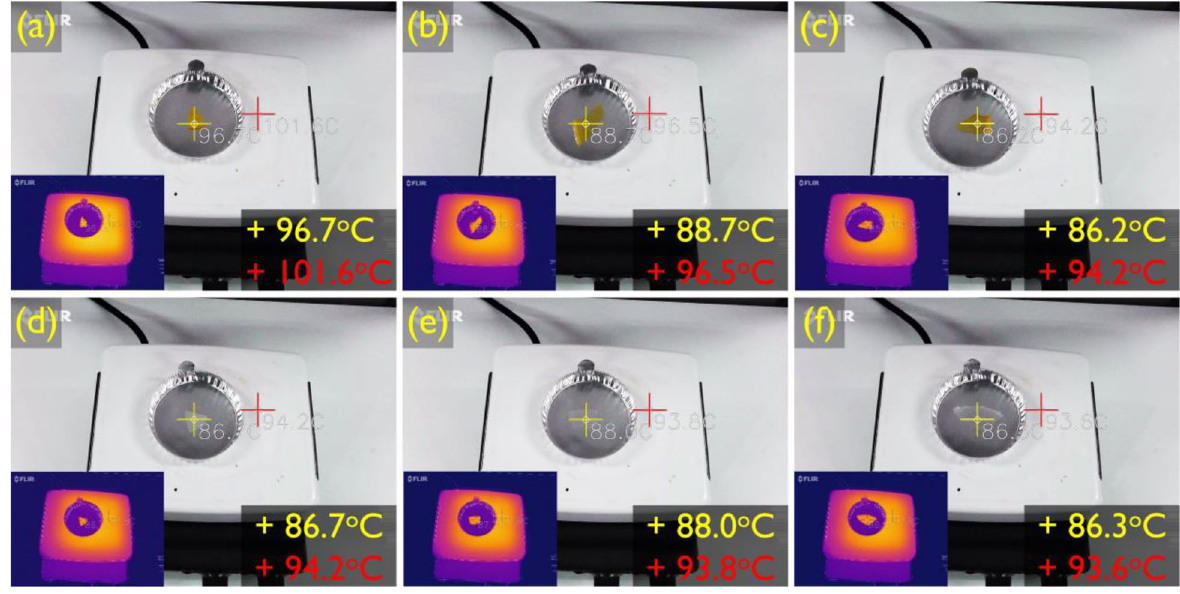
Figure 4. Images of the SSPCMs above 80 °C; ( a ) M.CO, ( b ) M.COM, ( c ) M.COT, ( d ) H.CO, ( e ) H.COM, and ( f )